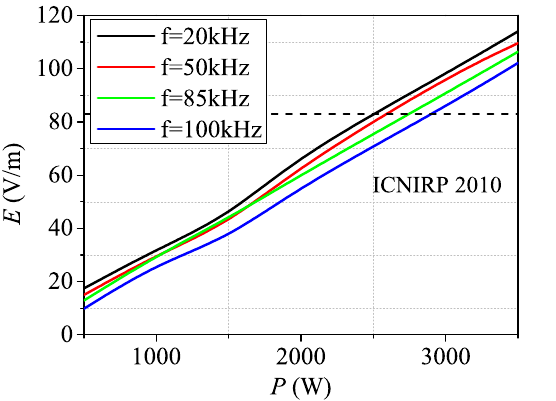
Figure 15. Measured results of E -field strength versus output power and operating frequency.